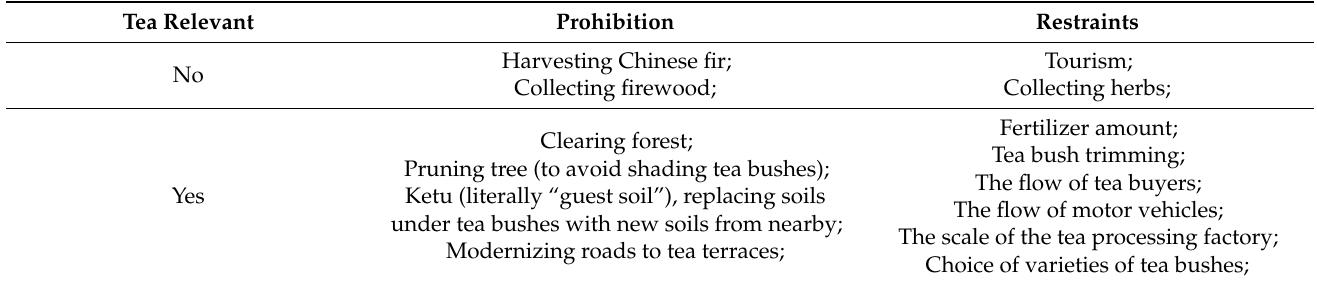
Figure 5. Perception of the impact of protected areas on tea orchard. Table 4. Identified disturbances to livelihood activities within the protected areas.